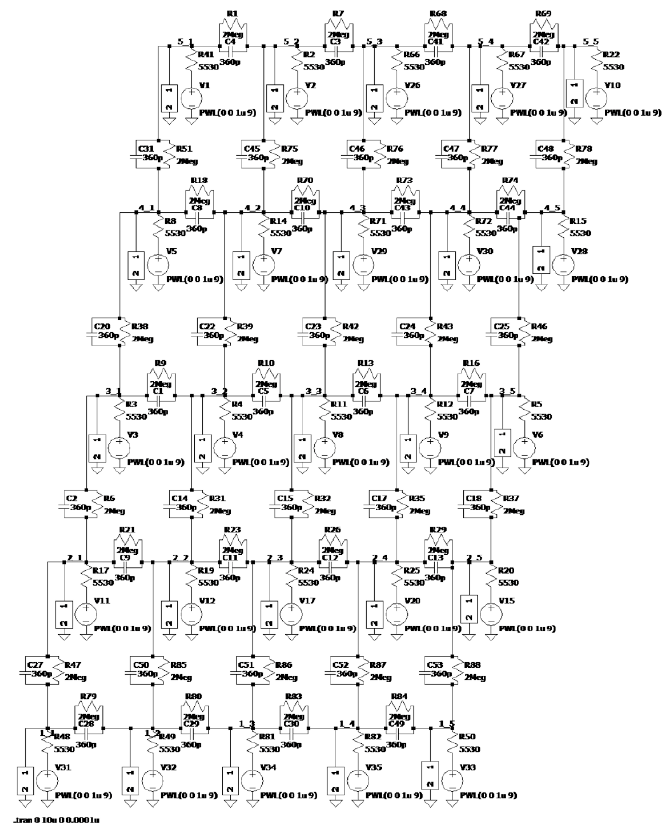
Figure 10. CNN composed of 5 × 5